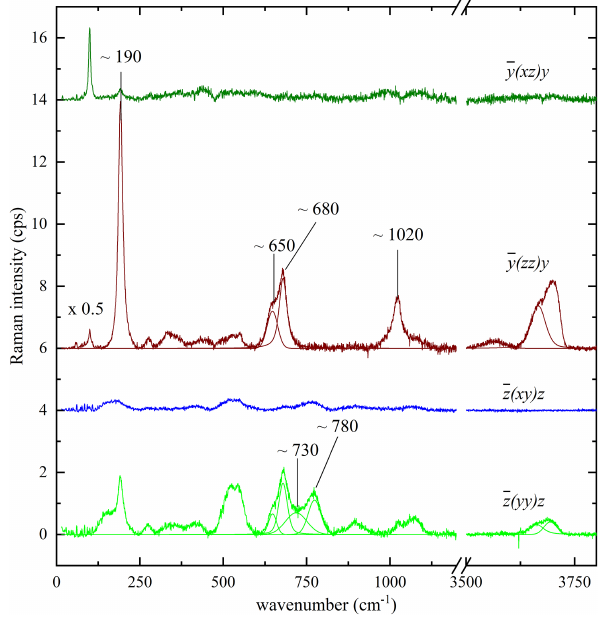
Figure 3. Raman spectra of phlogopite measured in four different scattering geometries, as described in the text. The spectra are ver- tically offset for